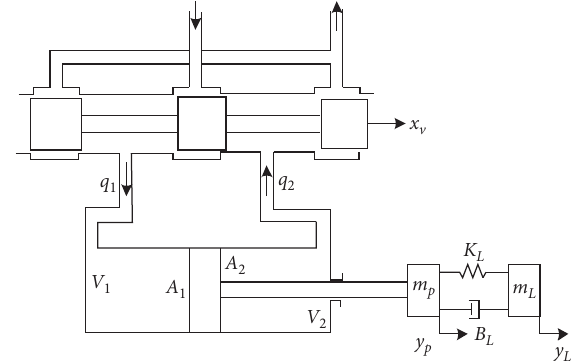
Figure 1: The model of the asymmetric cylinder system with flexible a left retraction. The linear flow continuity equation of the retraction motion is